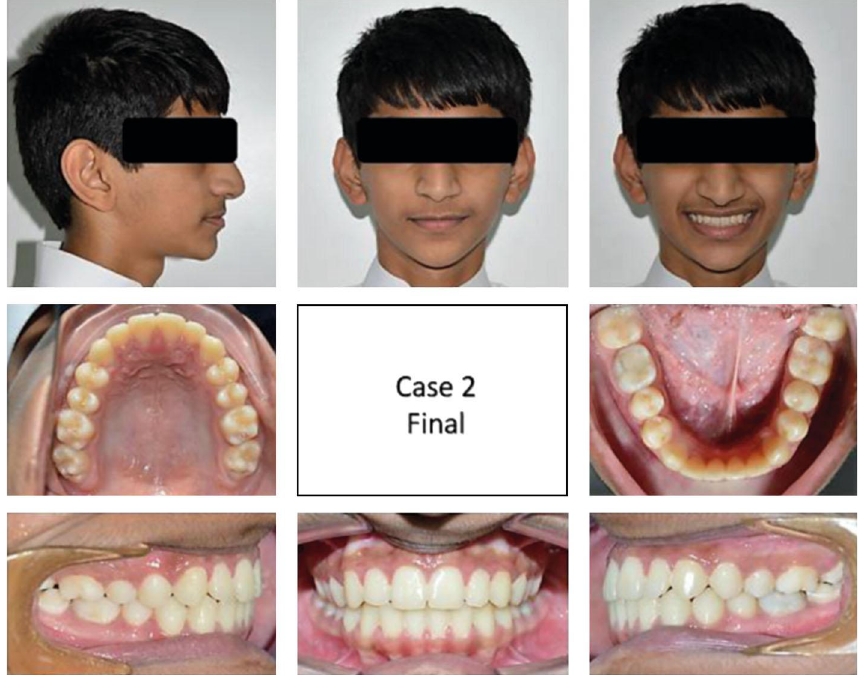
Figure 10: Posttreatment extraoral and intraoral photographs of the patient.